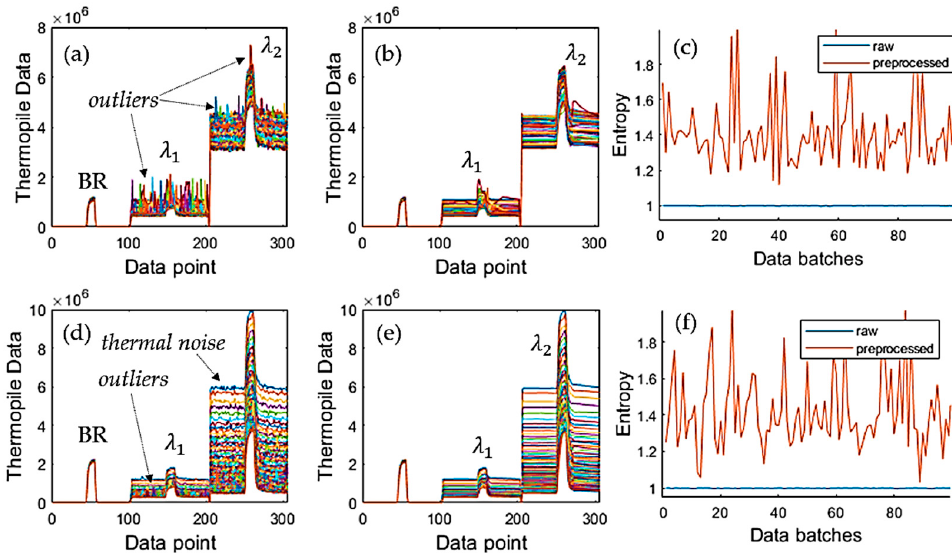
Figure 7. One hundred raw signals and their ACKF preprocessed signals when applying the ACKF in two different measurement sets. ( a , d ) Raw signal; ( b,e ) preprocessed signal and ( c,f ) entropies of the first-order differentiate corresponding to each signal.